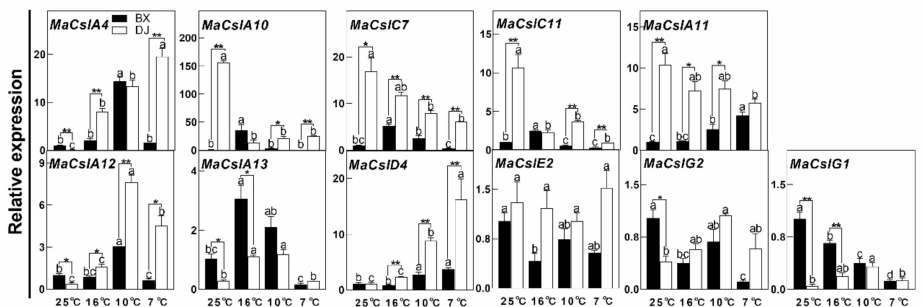
Figure 5. Quantitative real-time PCR (qPCR) analysis of 11 MaCsl gene expressions in banana ( Musa spp.) leaves under low temperature stress. The data represent an average of three replicates ± SE. Values followed by the same letter are not significantly different using Duncan’s multiple range test at p < 0.05 after the angular transformation of the data for each cultivar (comparison among different low-temperature points). Values marked with a star were considered significant at p < 0.05, while values marked with two stars were considered significant at p < 0.01 when evaluated using Student’s t -test (comparison between the two cultivars at the same low-temperature point). BX ‘Baxijiao’, chilling-sensitive; DJ ‘Dongguandajiao’,